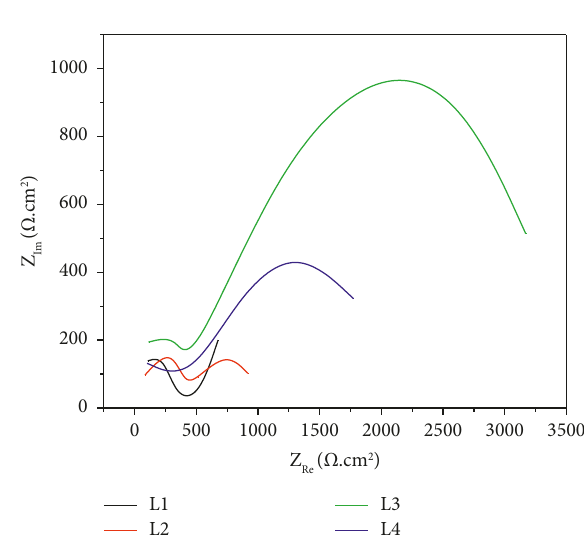
Figure 5: Nyquist diagram of the test piece at 84